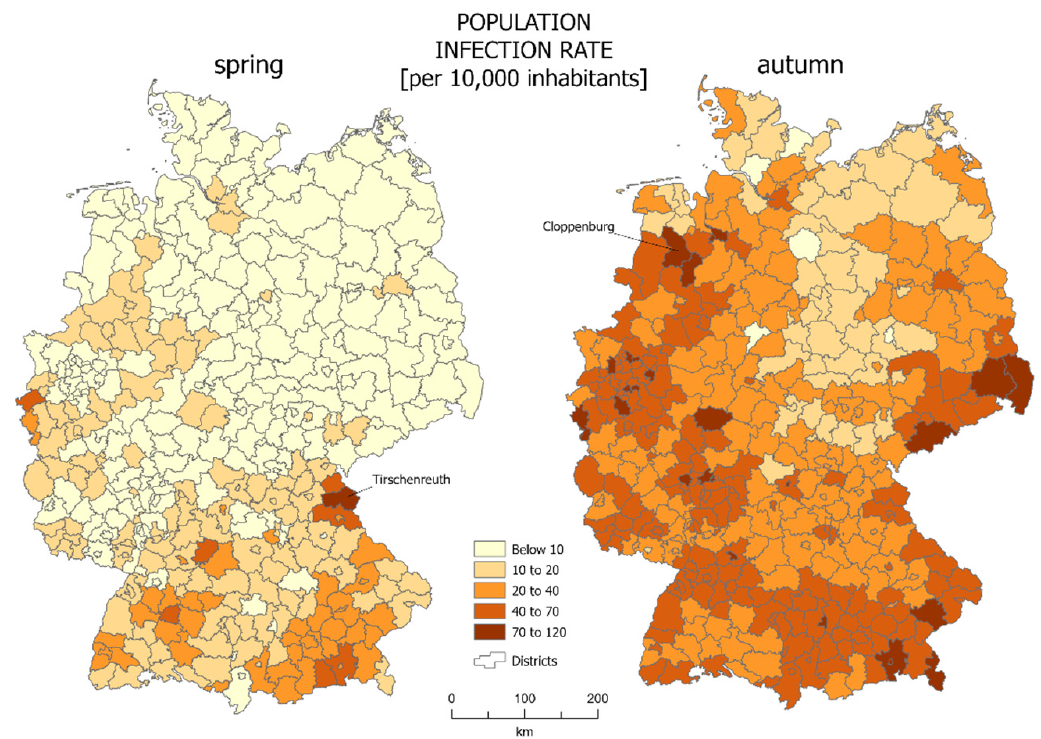
Figure 1. SARS-CoV-2 infections per 10,000 inhabitants in German districts—those with highest infection indicator for both periods are marked (source: own work).